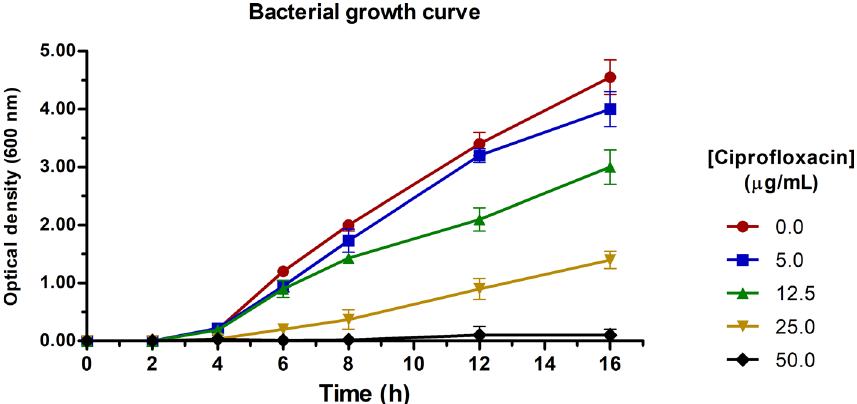
Figure 2. In vitro effects of ciprofloxacin on growth curve of PaeAG1. A growth rate reduction was observed as the CIP concentration was incremented. Area under curve (AUC) was compared using t-test (p < 0.05), showing a statistical difference between all curves when compared to control (0.0 mg/mL). In a similar manner, two-way ANOVA found differences in the OD 600nm and time for each